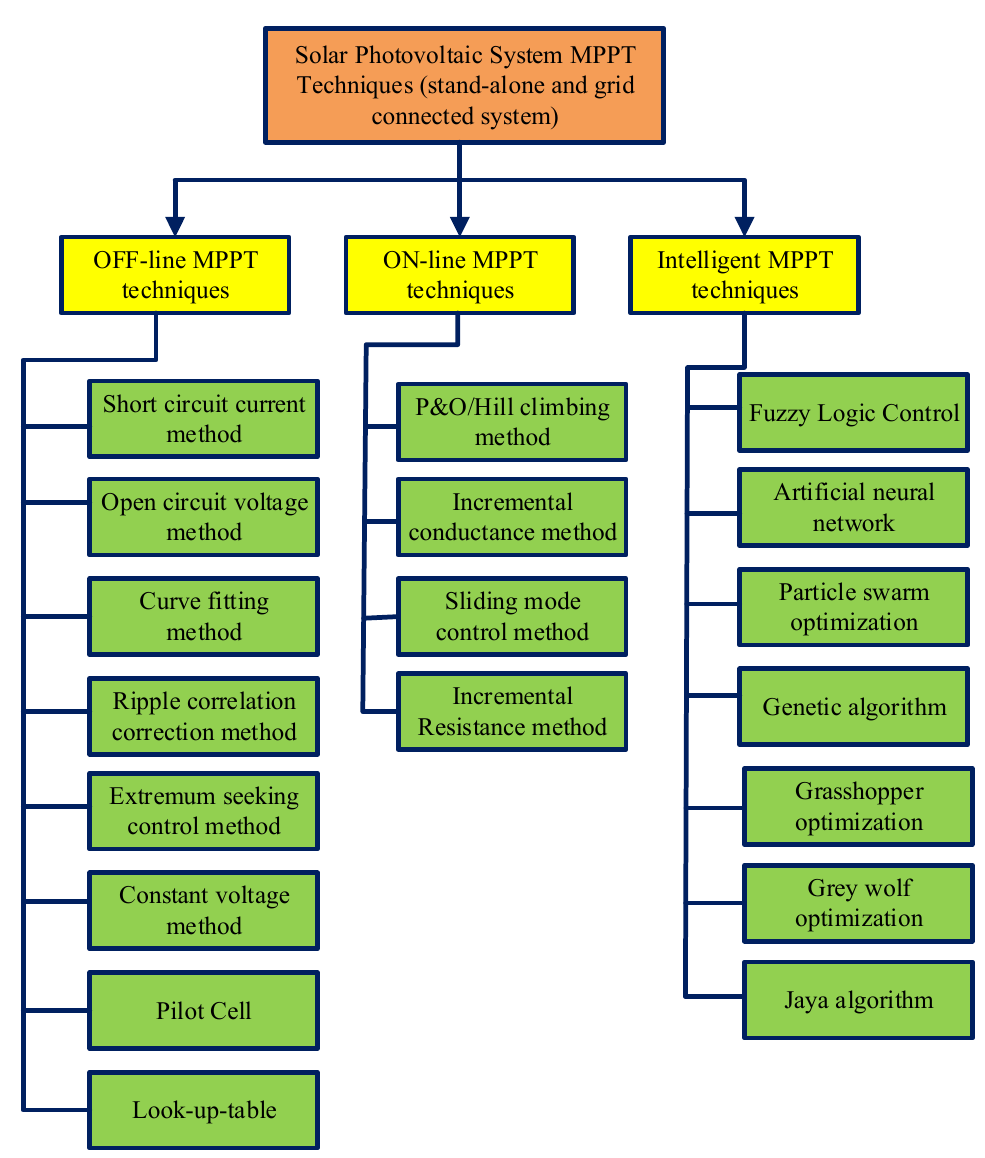
Figure 7. Classifications of MPPT techniques.